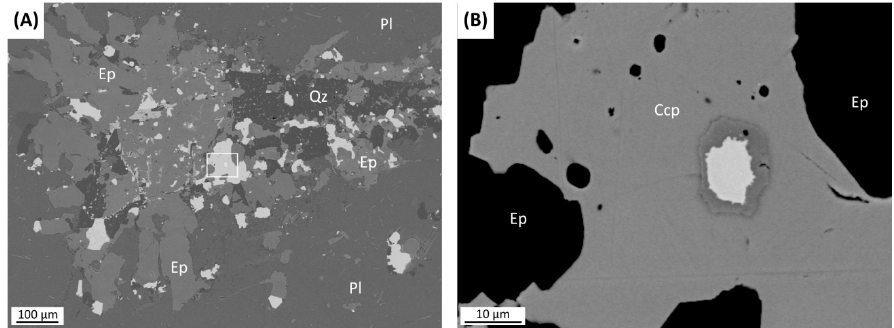
Figure 5. Back-scatter electron images of ( A ) finely-disseminated sulfides (light) intergrown with epidote, replacing the intercumulus space in the mineralized anorthosite and ( B ) baddeleyite rimmed by zircon hosted by chalcopyrite (Ccp). Abbreviations: Ep, epidote; Qz, quartz; Pl, plagioclase.